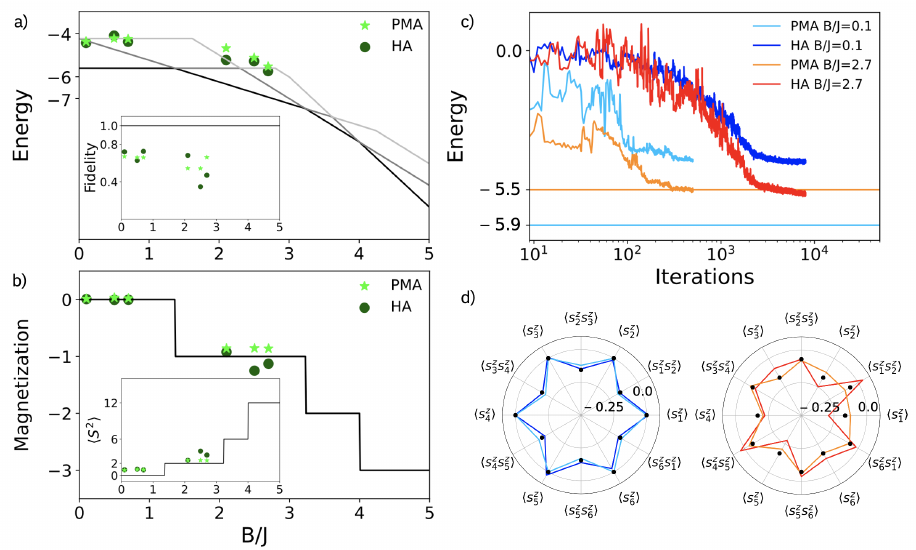
Figure 3. N = 6 spin ring noisy simulations, with a custom noise model derived by IBM Quantum chips with Quantum Volume 128, analogous to the N = 4 case reported in Figure 2. Ground state energy VQE results with corresponding fidelity ( a ), observables ( b , d ) and energy convergence ( c ). Results are generally worse compared to Figure 2, due to the increased complexity of the target model, but the PMA better reconstructs the ground state, with the correct symmetry (see observables in panels ( b , d